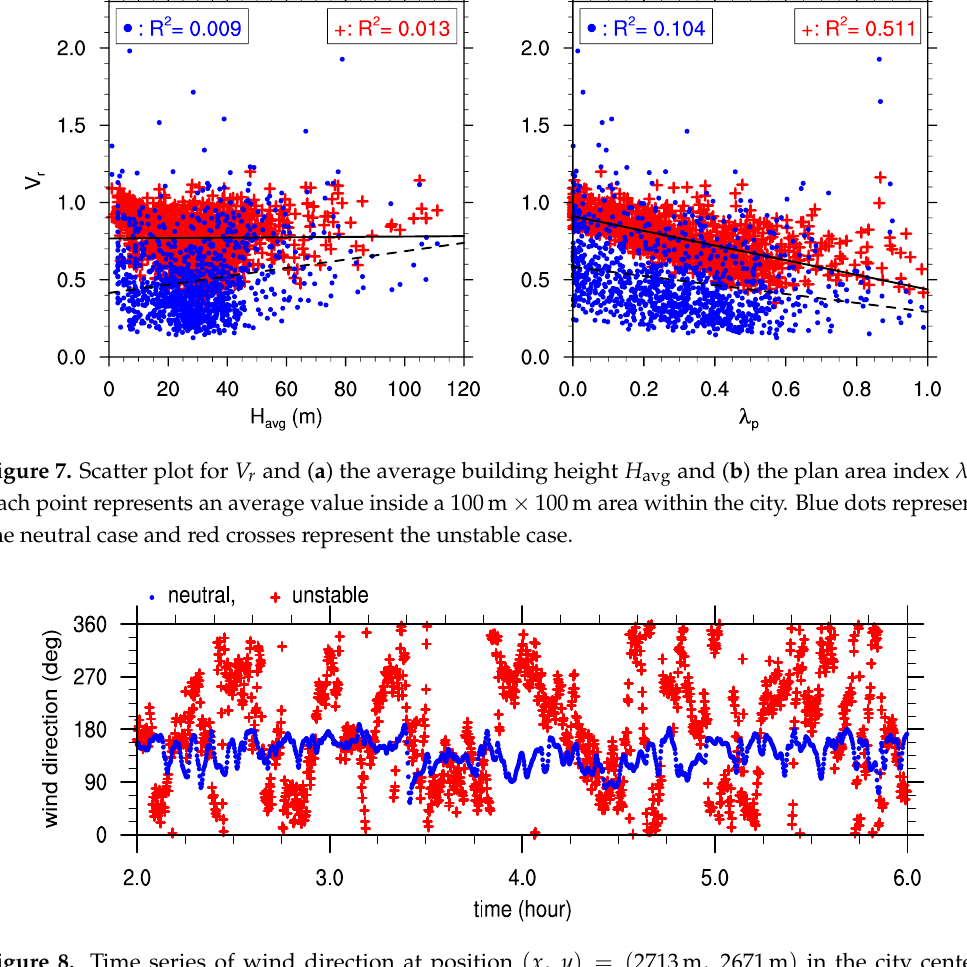
Figure 8. Time series of wind direction at position ( x , y ) = ( 2713m, 2671m ) in the city center. Blue dots represent the neutral case and red crosses represent the unstable